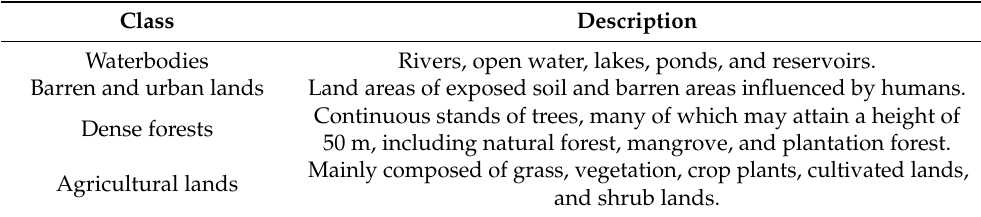
Table 2. The classification scheme for land use and land cover (LULC).